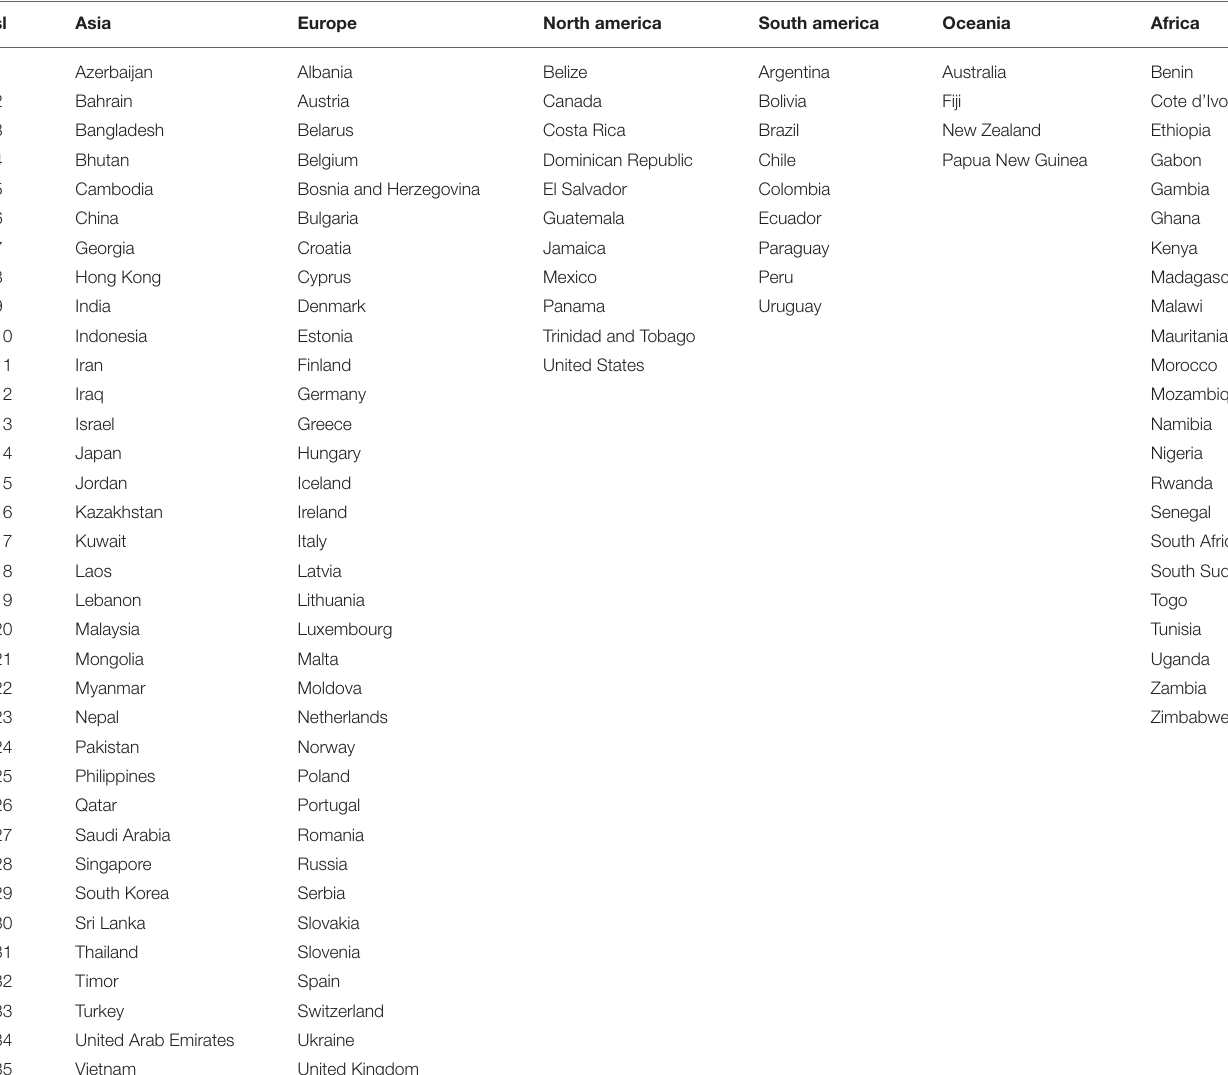
TABLE 1 | List of countries